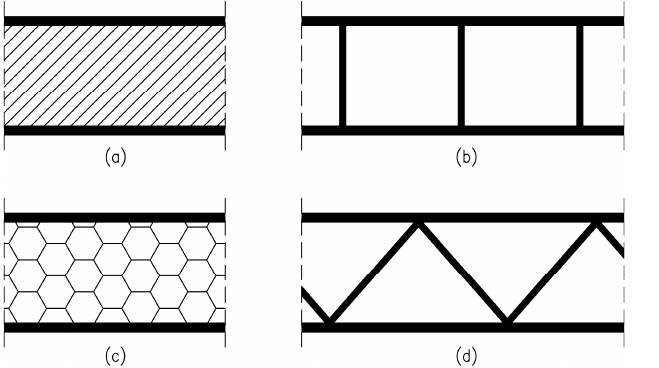
Figure 7. Basic types of cores in sandwich panels: ( a ) foam filling, ( b ) vertical webs, ( c ) honeycomb structure, ( d ) truss core; based on [49].